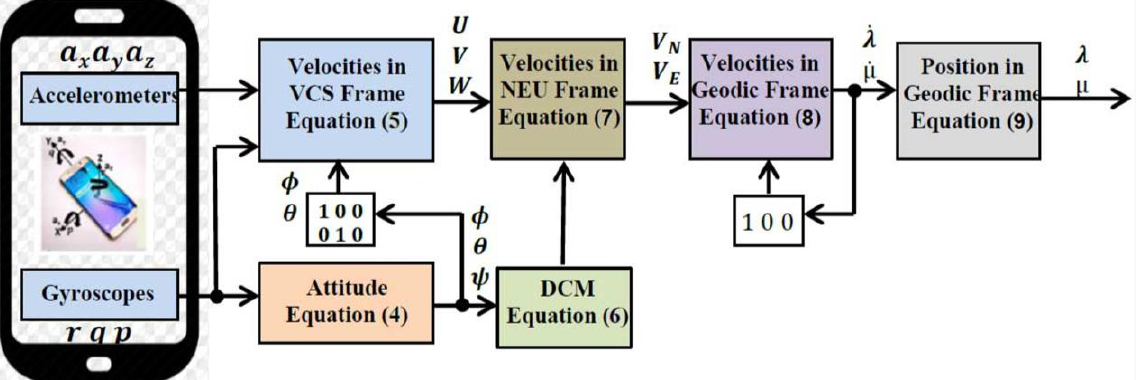
Figure 1. Algorithm of MEMS – INS navigation.